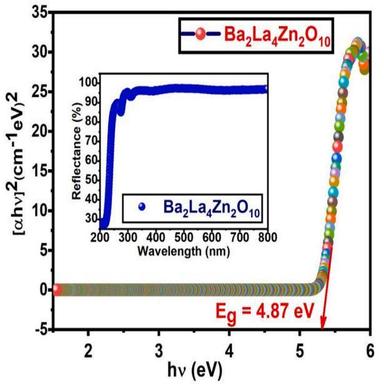
Tauc's plot to determine band-gap (Eg) for host matrix Ba2La4Zn2O10.